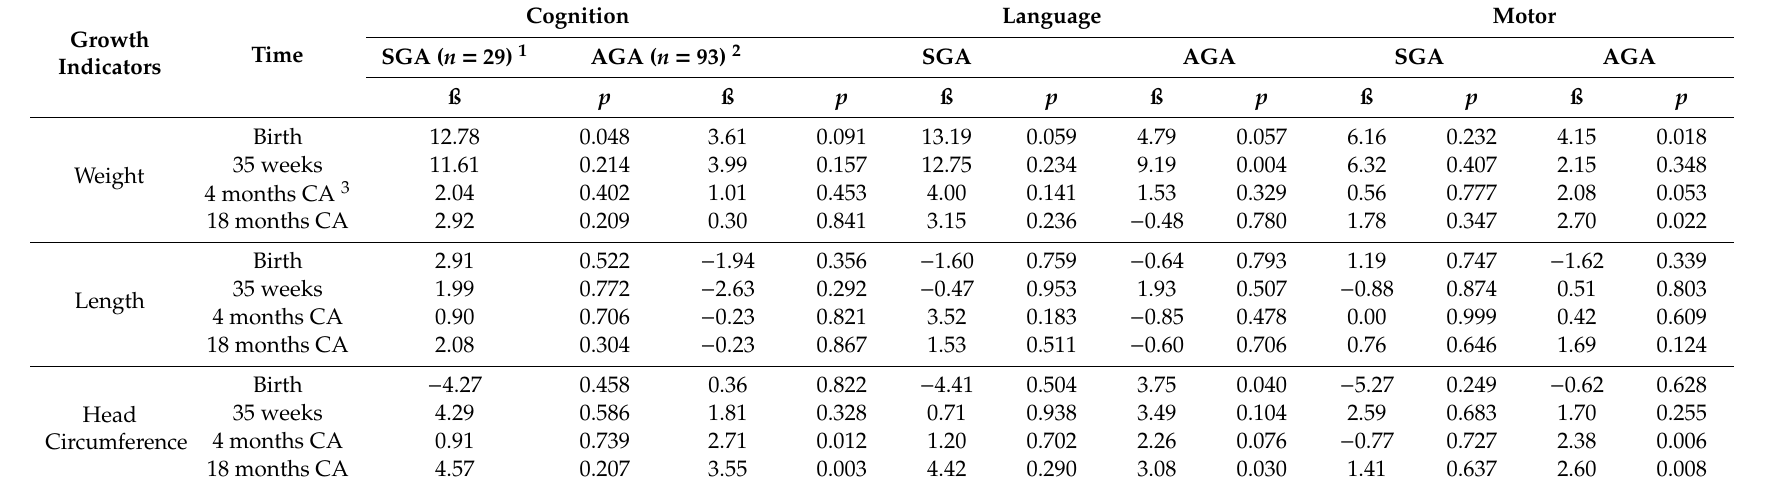
Table 2. Correlations between growth indicators after birth and 18-month Bayley